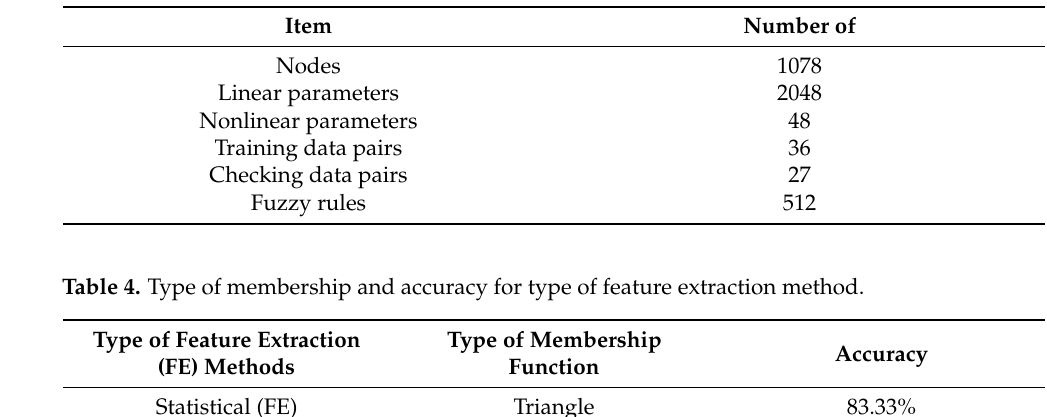
Table 3. ANFIS system parameters.